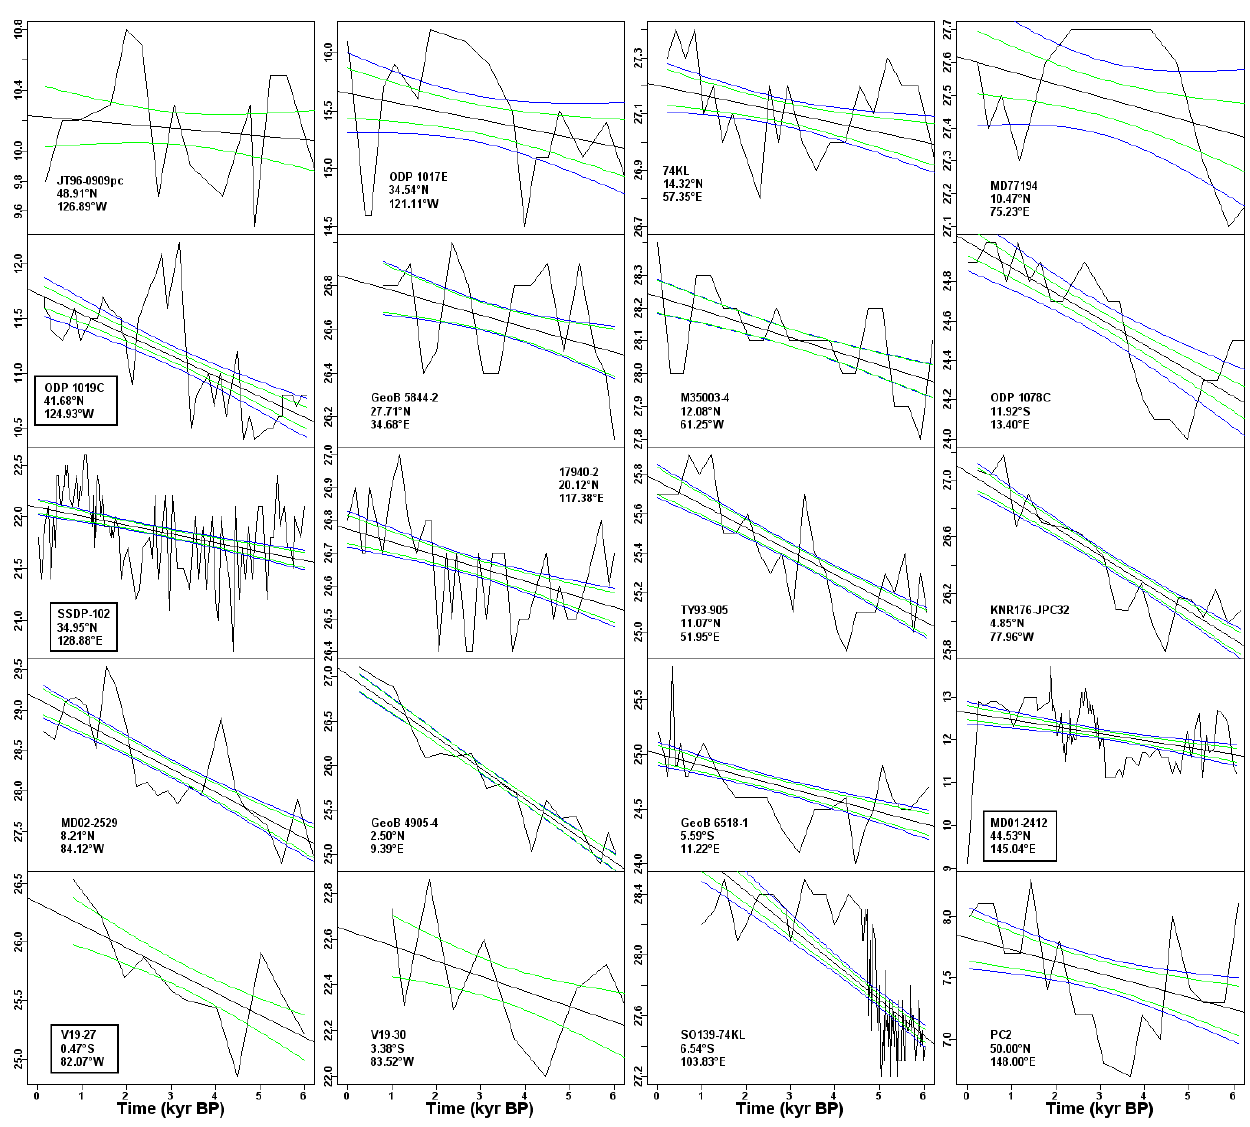
Fig. 1. Alkenone time series with positive linear trends and their standard errors. The blue curved lines represent the standard error that accounts for serial correlation, the green ones represent those not accounting for serial correlation. Name and position are included in the panels and in Table 1. The inserts provide information about the core location. Boxed inserts indicate cores which fail the residual test for randomness of the proxy linear regressions’ residuals as described in Sect.